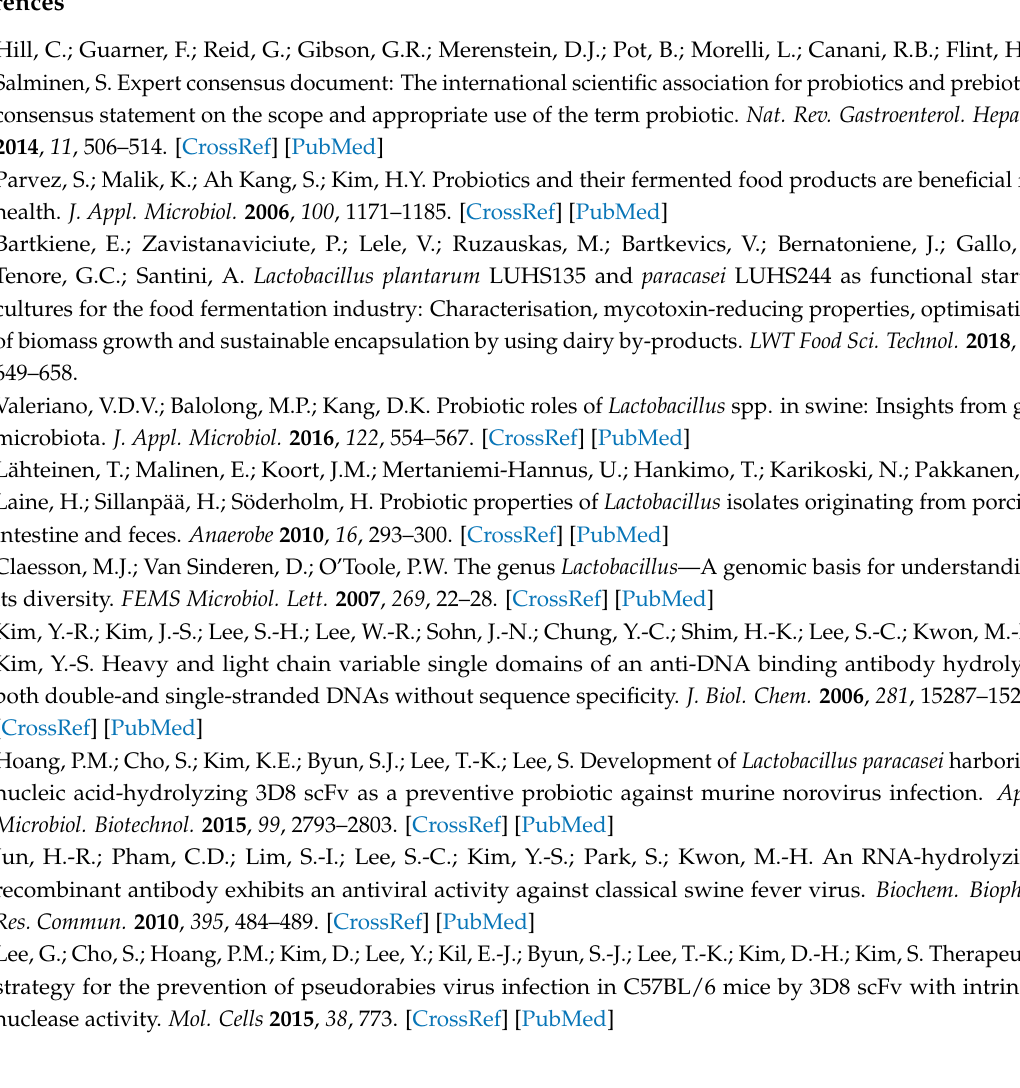
Table S1: Classification of identified 396 OTUs identified from 18 samples with respective bacteria taxonomy and read number., Table S2: Statistical analyses of 53 bacterial genera in 18 different samples by ANOVA implemented in STAMP program., Table S3: Read number, mean value, and standard deviation for the identified 396 species in each